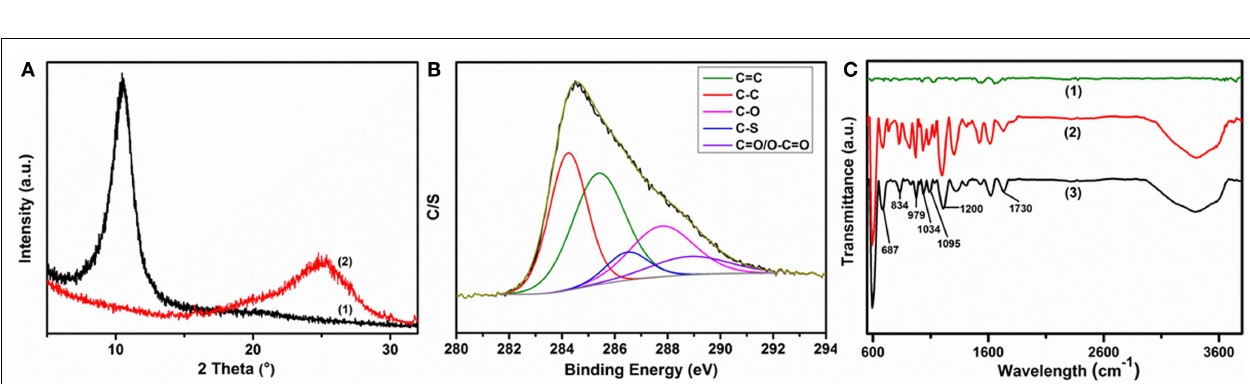
FIGURE 5 | Chemical reduction effects on as-prepared composite materials: (A) change in XRD patterns of (1) GO-PP 25 and (2) rGO–PP 25 composites; (B) XPS core level spectra of rGO–PP 25 composite in the carbon region; and (C) comparative FT-IR spectra of (1) rGO, (2) GO-PP 25, and (3) rGO–PP 25 composites